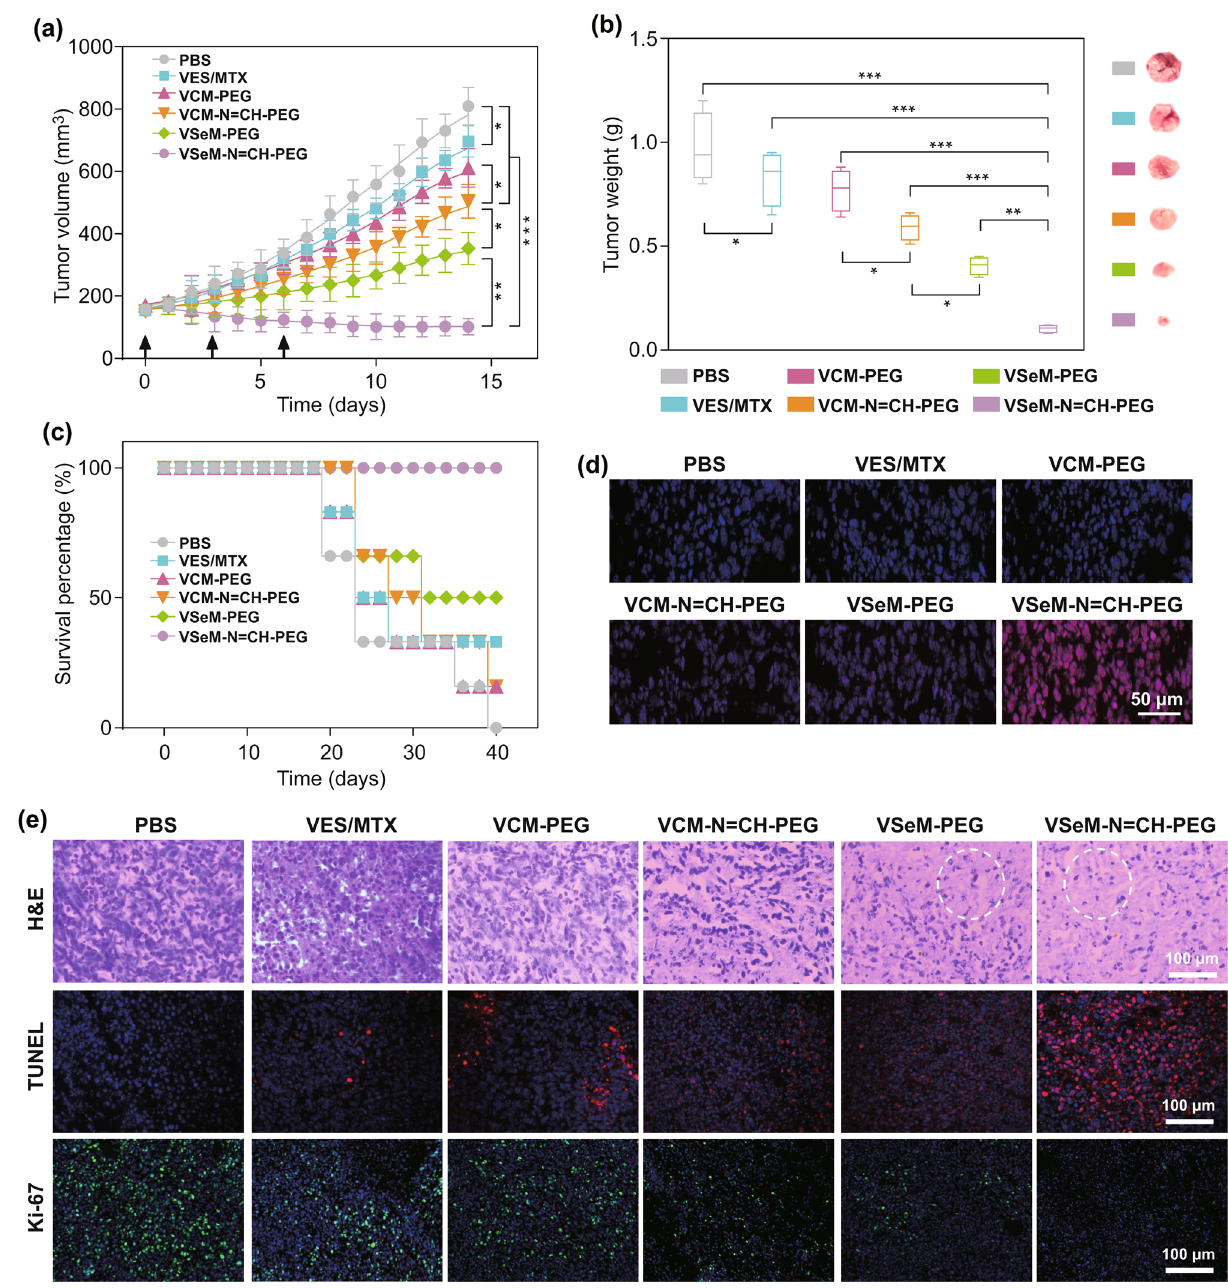
Fig. 5 In vivo anti-tumor effects of VSeM-N=CH-PEG. a Tumor growth profiles of HeLa tumor-bearing nude mice after different treatments with PBS, VES/MTX, VCM-PEG, VCM-N=CH-PEG, VSeM-PEG, and VSeM-N=CH-PEG at equivalent MTX concentration (4 mg kg −1 ) dur- ing 14 days. b Tumor weight excised from HeLa tumor-bearing nude mice on the 14th day. c Survival percentage of HeLa tumor-bearing nude mice after different treatments. d Cellular ROS levels in tumor excised from mice by dihydroethidium (DHE) staining on the 2nd day. e Repre- sentative images of H&E, TUNEL, and Ki-67-stained tumor sections, respectively. White circles indicated cell apoptosis. * P < 0.05, ** P < 0.01, *** P <